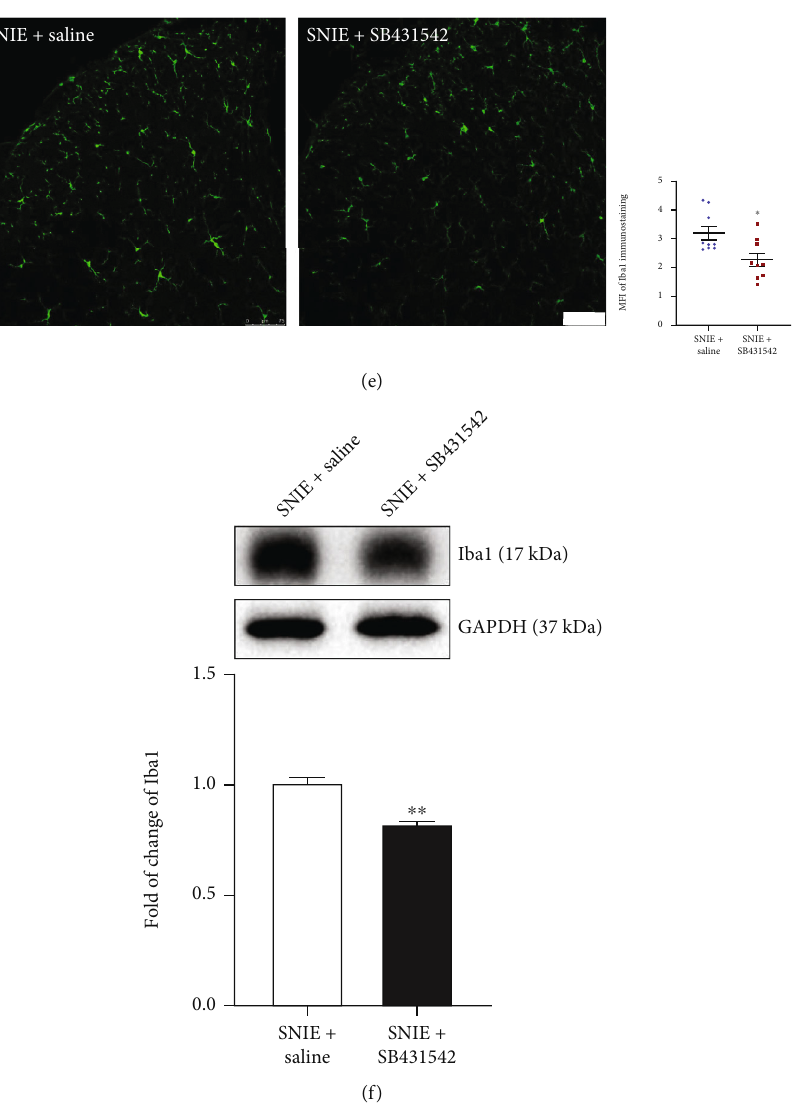
Figure 6: TGF β RI inhibitor reverses exercise analgesia. (a, b) Mechanical and cold allodynia tests ( n = 8 ). The blue shade represents the period of the exercise intervention, and the gray arrow represents the time of injection. & P < 0 : 05 , && P < 0 : 01 versus the SNIE+saline group. (c) Quanti fi cation of GFAP in the spinal dorsal horn. Values represent the mean ± SEM ( scarbar = 75 μ m, n = 9 spinal slices from three mice for each group). (d) Western blotting analysis for the expression changes of GFAP ( n = 8 ).(e) Quanti fi cation of Iba1 in the spinal dorsal horn. Values represent the mean ± SEM ( scar bar = 75 μ m, n = 9 spinal slices from three mice for each group). (f) Western blotting analysis for the expression changes of Iba1 ( n = 8 ). Values represent the mean ± SEM . ∗ P < 0 : 05 , ∗∗ P < 0 : 01 versus the SNIE +saline